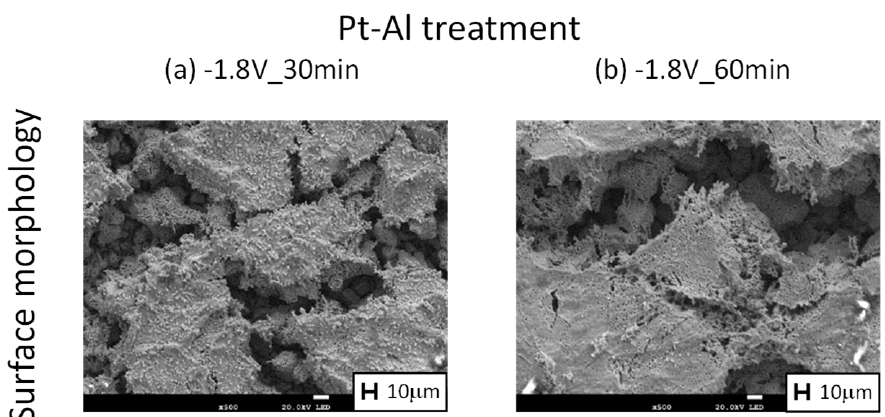
Figure 6. Surface morphology of Al porous sample after Pt electrodeposition. ( a ) Al electrodeposition − 1.8 V, 30 min, ( b ) Al electrodeposition − 1.8 V, 60 min.